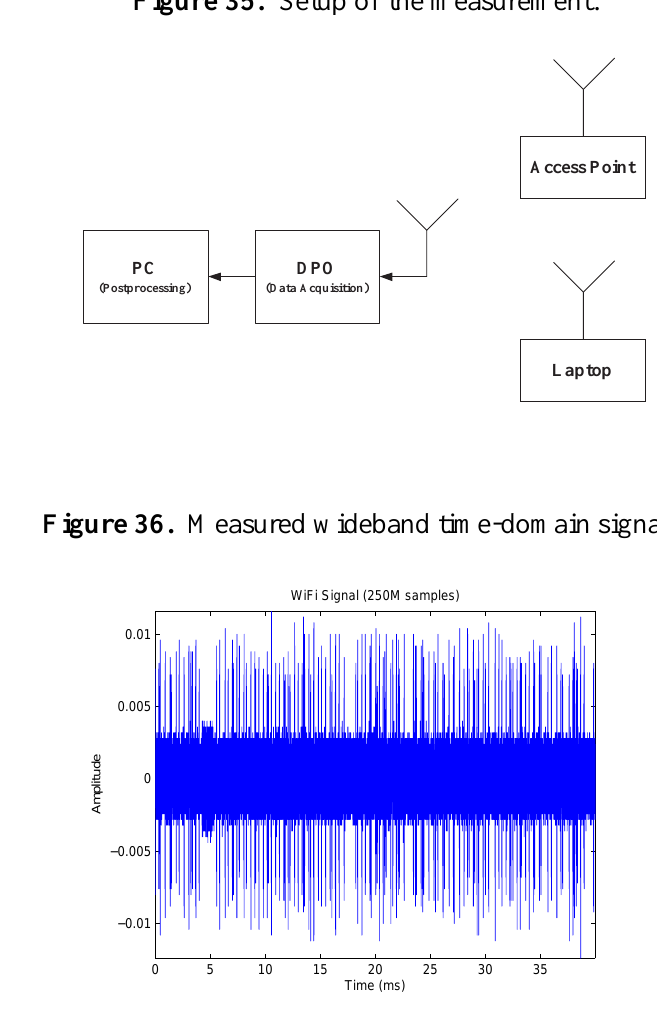
Figure 35. Setup of the measurement.